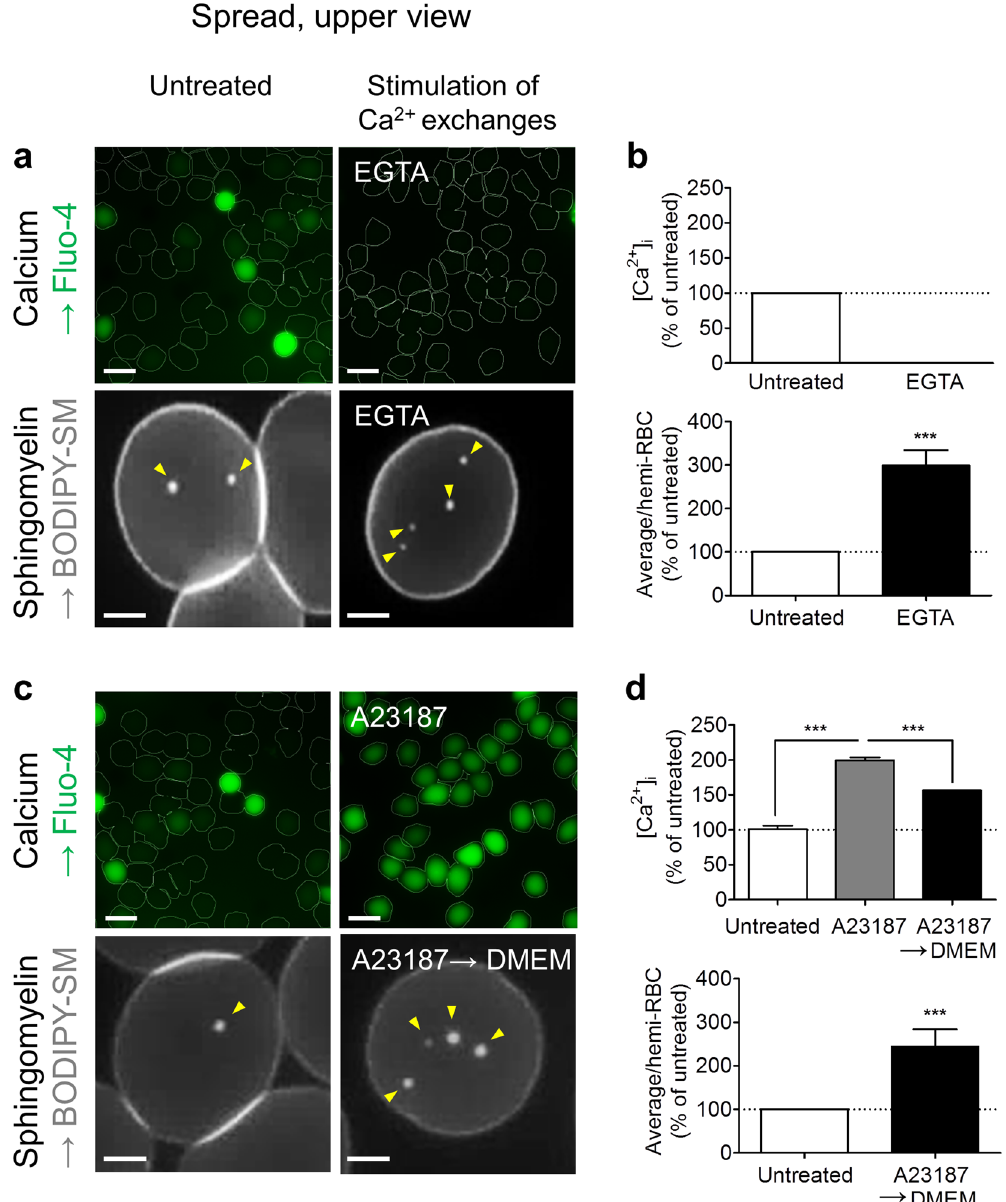
Figure 7. Increase of SM-enriched domains during calcium efflux. Fresh healthy RBCs were either left untreated ( open bars ) or stimulated for Ca 2 + exchanges ( black & grey bars ), either by incubation with EGTA in Ca 2 + -free medium ( a,b ) or by treatment with the Ca 2 + ionophore A23187 followed or not by a reincubation in A23187-free medium ( c,d ). RBCs were then labelled with Fluo-4 or BODIPY-SM, washed and either spread onto PLL-coated coverslips and visualized by vital confocal/fluorescence microscopy ( a,c and lower panels in b,d ) or left in suspension and evaluated for Fluo-4 intensity by spectrophotometry ( upper panels in b,d ). ( a , c ) Representative imaging. In lower panels , on representative RBC; y ellow arrowheads indicate domains in LC membrane area. Representative imaging of 3–7 independent experiments, s cale 10 µ m in upper panel and 2 µ m in lower panel . ( b , d ) Quantification of Fluo-4 intensity ( upper panels ; average intensity by sample expressed as a percentage of untreated RBCs) and domain number ( lower panels ; average number by hemi-RBC expressed as a percentage of untreated RBCs). Results are means ± SEM of 11–12 samples ( upper panels ) and 82–1654 RBCs ( lower panels ) from 3–7 independent experiments. Statistical significance was tested with two-sample t-tests, except one-way ANOVA followed by Tukey’s post-hoc test in upper panel in